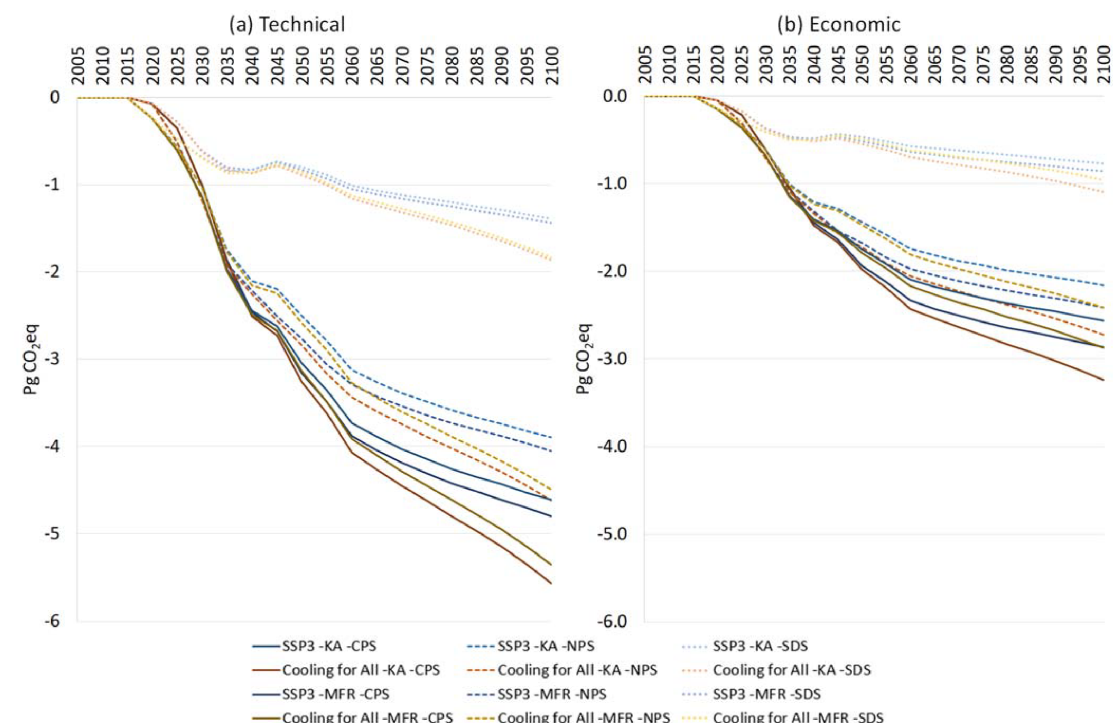
Figure 5. Annual greenhouse gas emission reductions from electricity savings in the Kigali Amendment (KA) and maximum technically feasible reduction (MTFR) scenarios relative to the pre-Kigali baseline scenarios (SSP3 and Cooling for All). Results for technical energy efficiency improvements are shown in (a) and for economic energy efficiency improvements in (b)